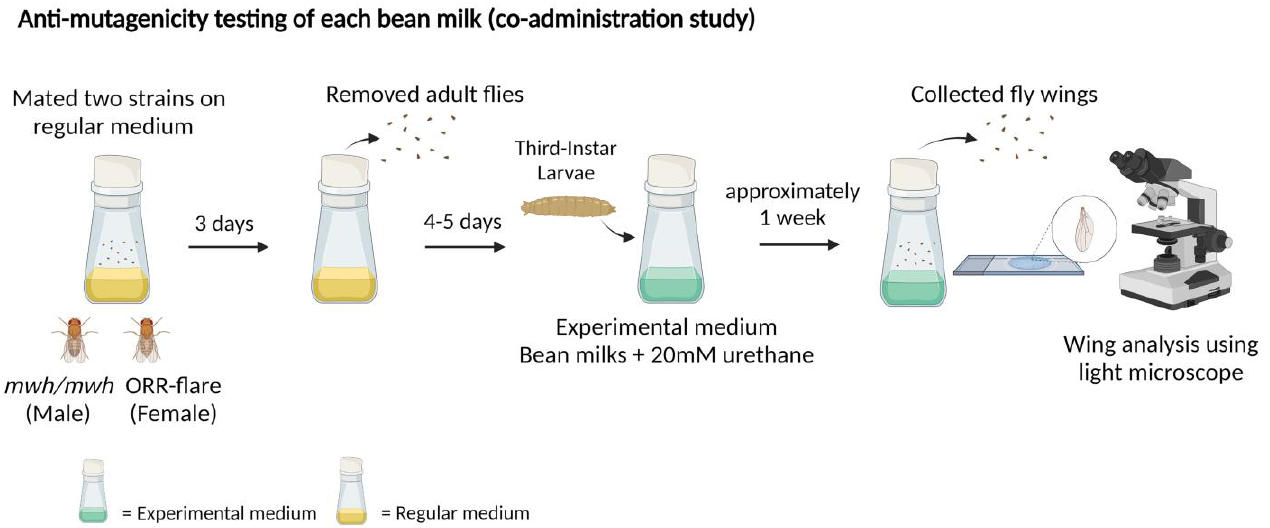
Figure 3. Experimental design of the co-administration study for anti-mutagenicity testing: crossed adult flies were fed on the regular medium, and the third instar larvae were transferred to the experimental medium containing each bean milk + 20 mM urethane. Wings were collected and analyzed for mutant spots.